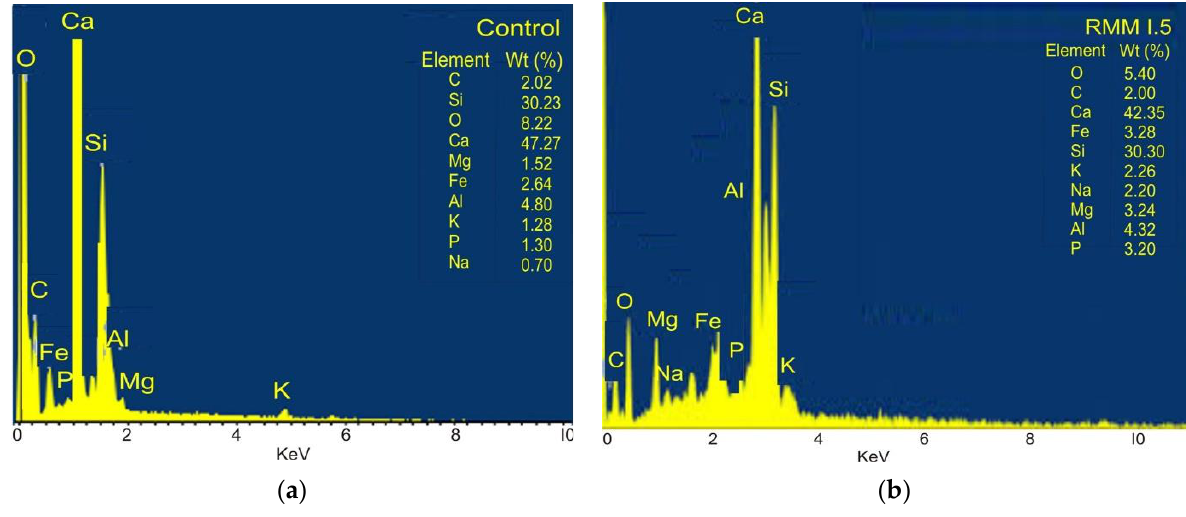
Figure 10. EDS analysis ( a ) control mortar mix ( b ) best fibre-reinforced mortar mix.